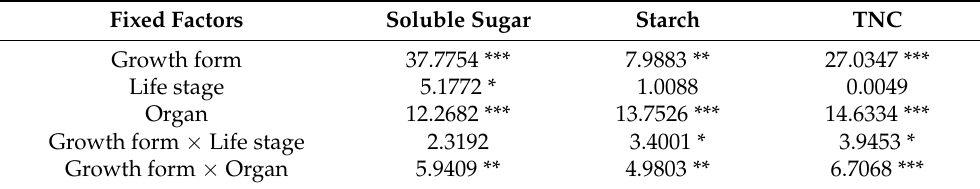
Table 2. Results of mixed linear models for factors affecting NSC concentration. The NSC concentra- tion was used as the dependent variable, life stage, growth form, and organ. Their interactions were used as fixed factors, and different individuals were used as random factors.